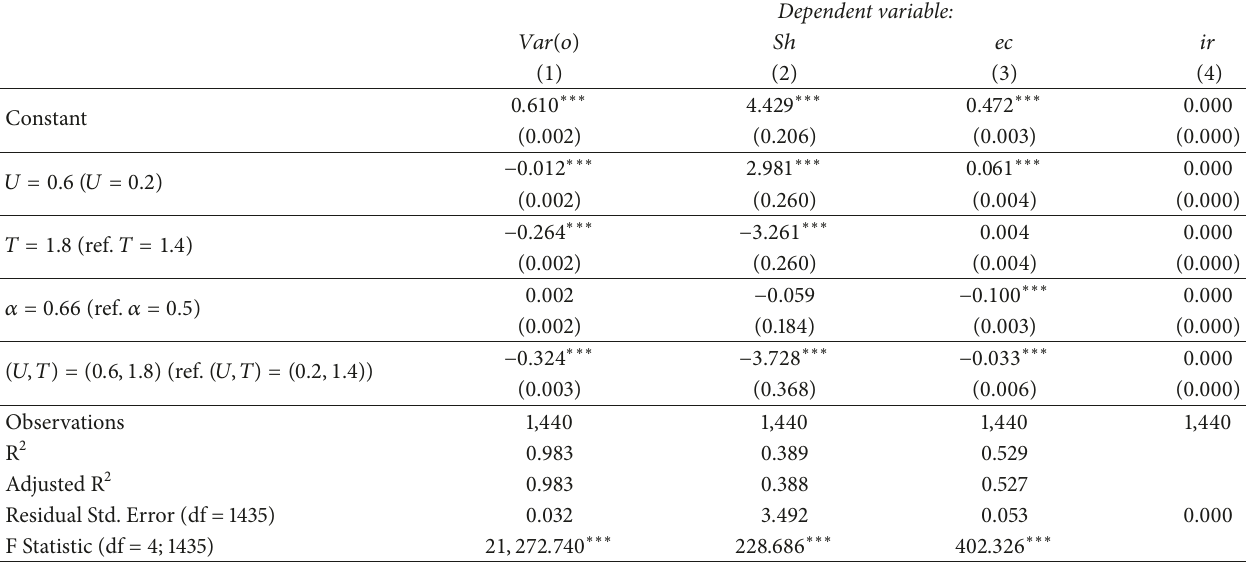
Table 3: Ordinary least squares estimates for pair-wise interactions scenarios for most of the observed